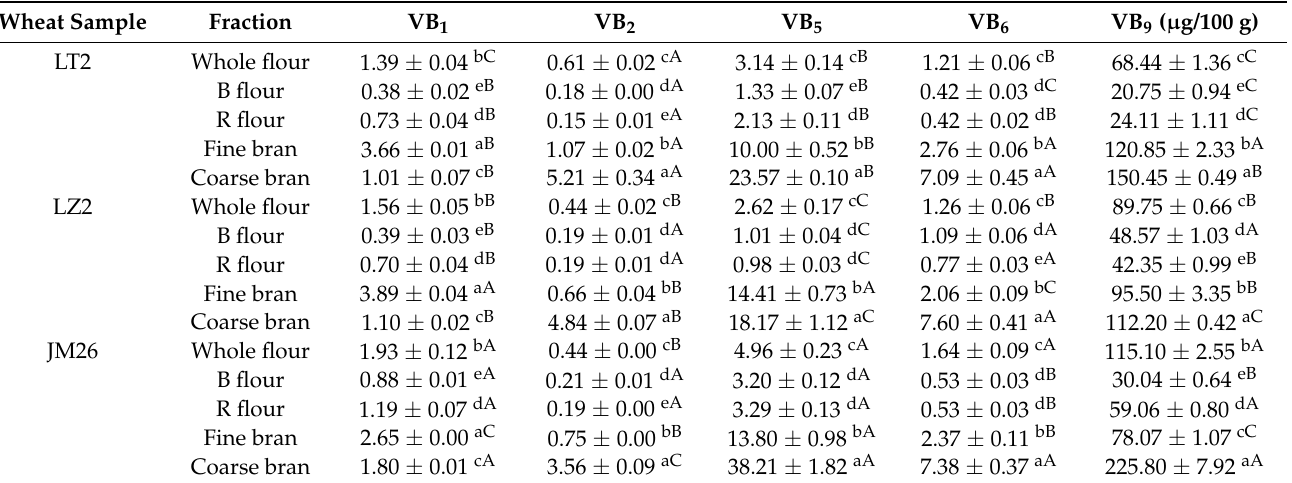
Table 3. Vitamin B contents ( µ g/g) of the milling fractions of LT2, LZ2, and